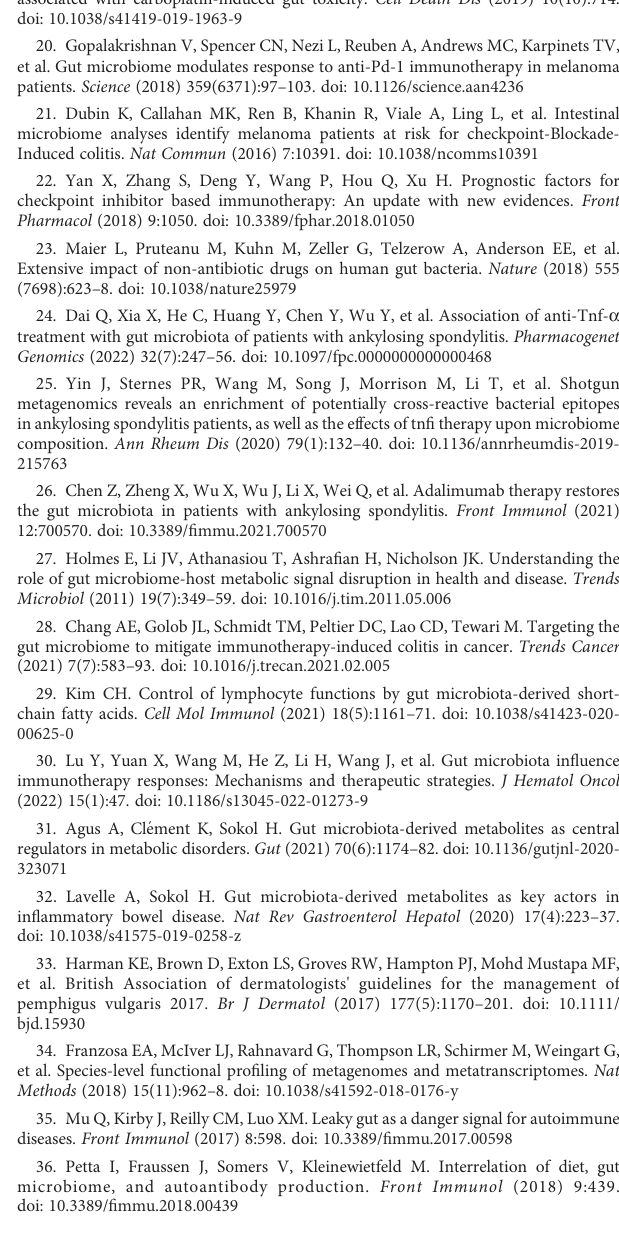
LDA effect size analysis; LDA, linear discriminant analysis; KEGG, Kyoto encyclopedia of genes and genomes. SUPPLEMENTARY FIGURE 3 Different MetaCyc pathways between PV patients and healthy controls. SUPPLEMENTARY TABLE 1 Clinical information for all